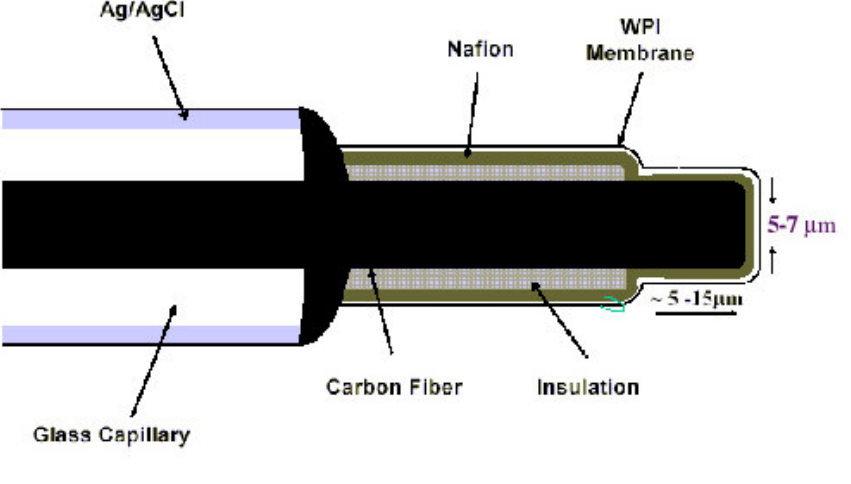
Figure 1 . Modified WPI integrated amperometric NO sensing electrode. The basic features of the electrode structure are shown. Arrow pointing to insulation layer refers to either epoxy or glass coatings. The NO sensitive length, coated with Nafion and a WPI membranes was approximately 5 -15 m m; the tip diameter varied from 5 to 7 m m. See Methods for additional